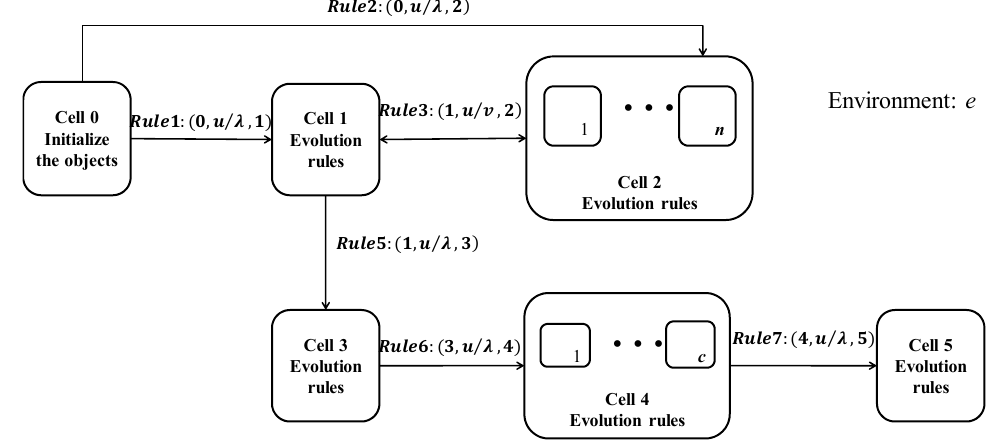
Figure 4. The basic structure of the coupled P system.